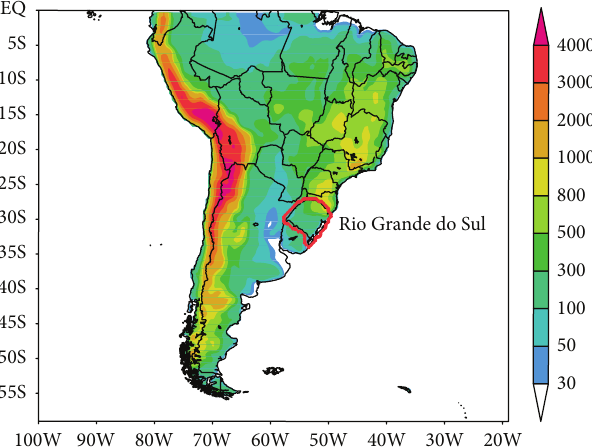
Figure 1: The topography model domains and the Rio Grande do Sul state highlighted (height contours are expressed in